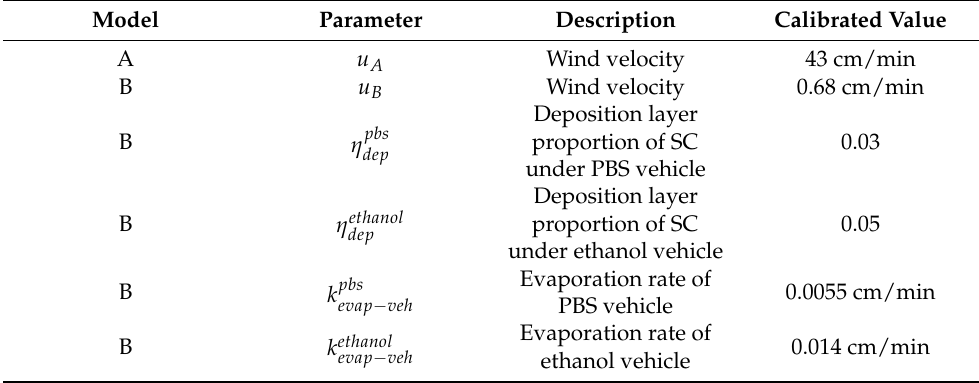
Table 3. Summary of calibration results for Models A and